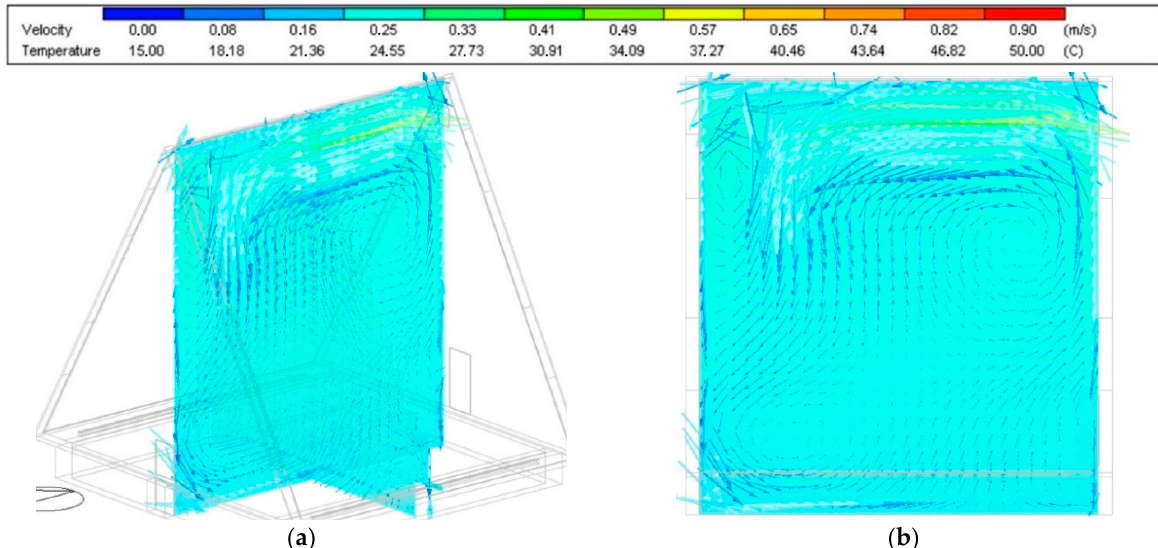
Figure 13. Simulated airflow paths on 6.6. at 6:00 p.m. in position of: ( a ) transverse sections; ( b ) longitudinal section.